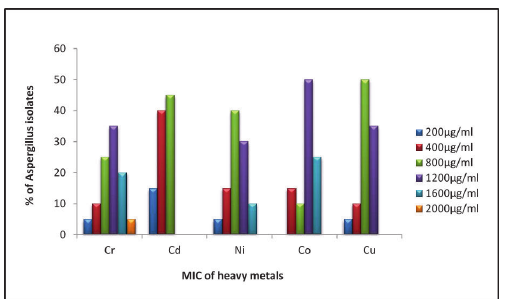
Fig. 4. Heavy metal tolerance (MIC) among 20 Aspergillus isolates.